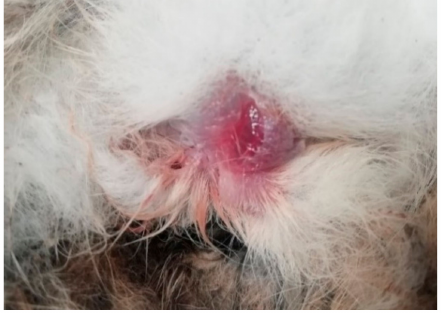
Figure 2. Oedema of the vulva (Female